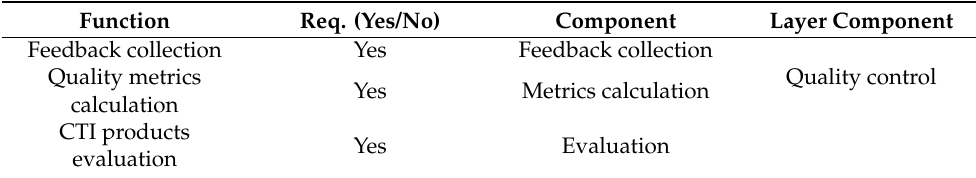
Table 9. Application of CTI Reference Model: Quality Control